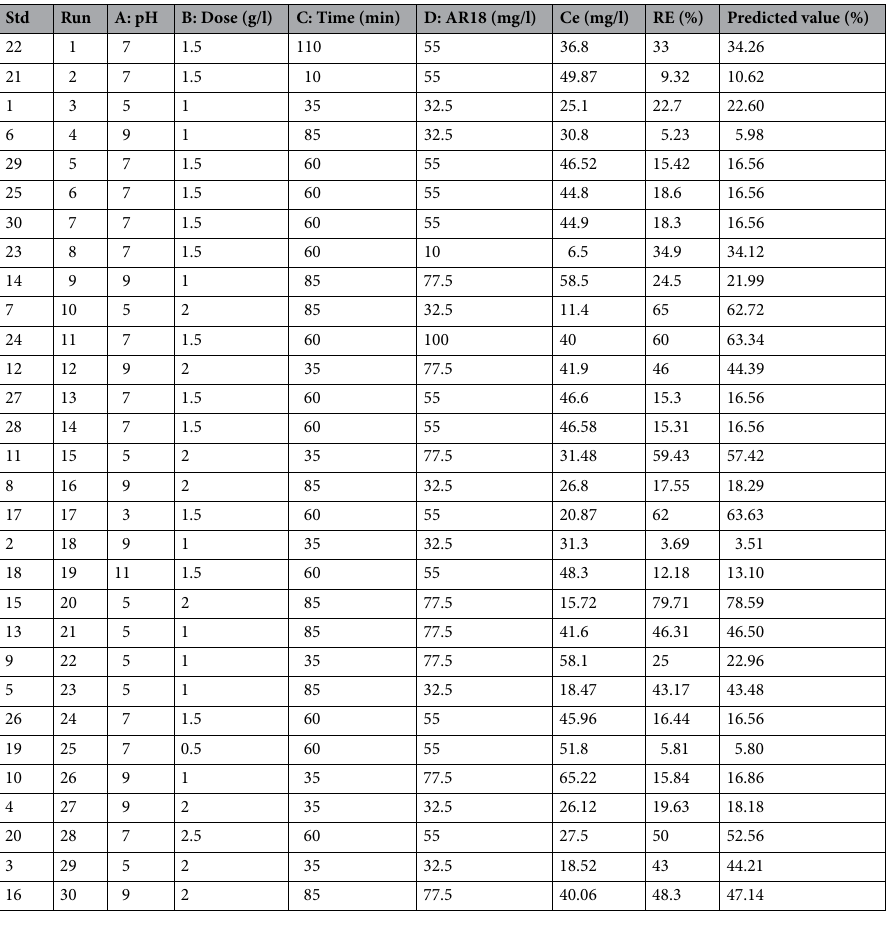
Table 3. CCD design for AR18